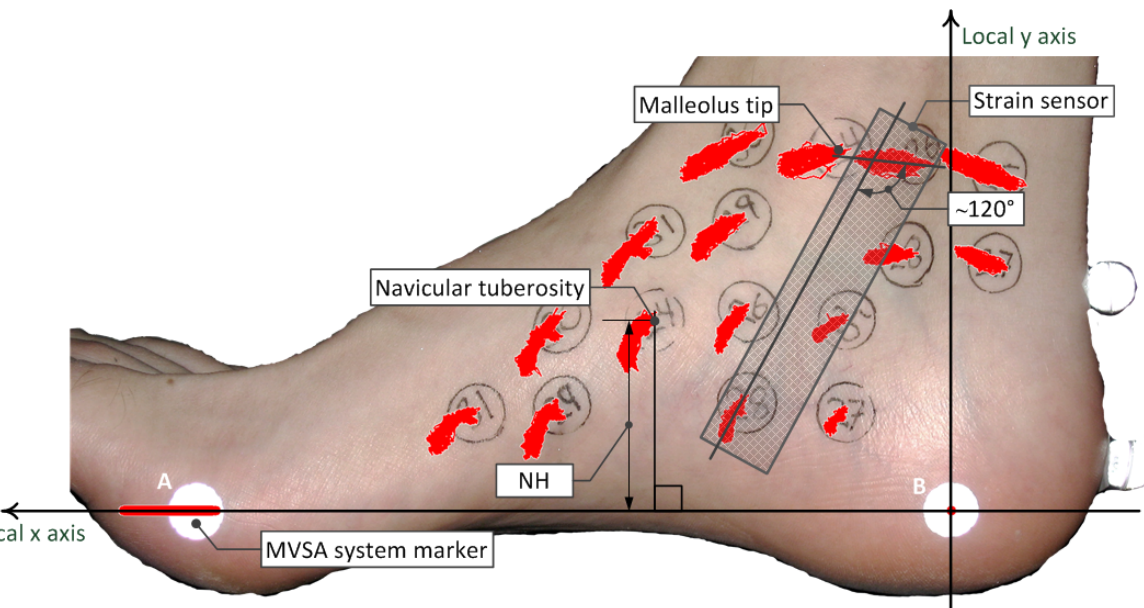
Figure 2. A set of measurements were performed using the MVSA system, and the measurements were combined, to locate the optimal position of a strain sensor. The red point clouds on different positions of the foot illustrate the marker displacement during gait at that particular position relative to the points A and B. The optimal position is illustrated by position of the strain